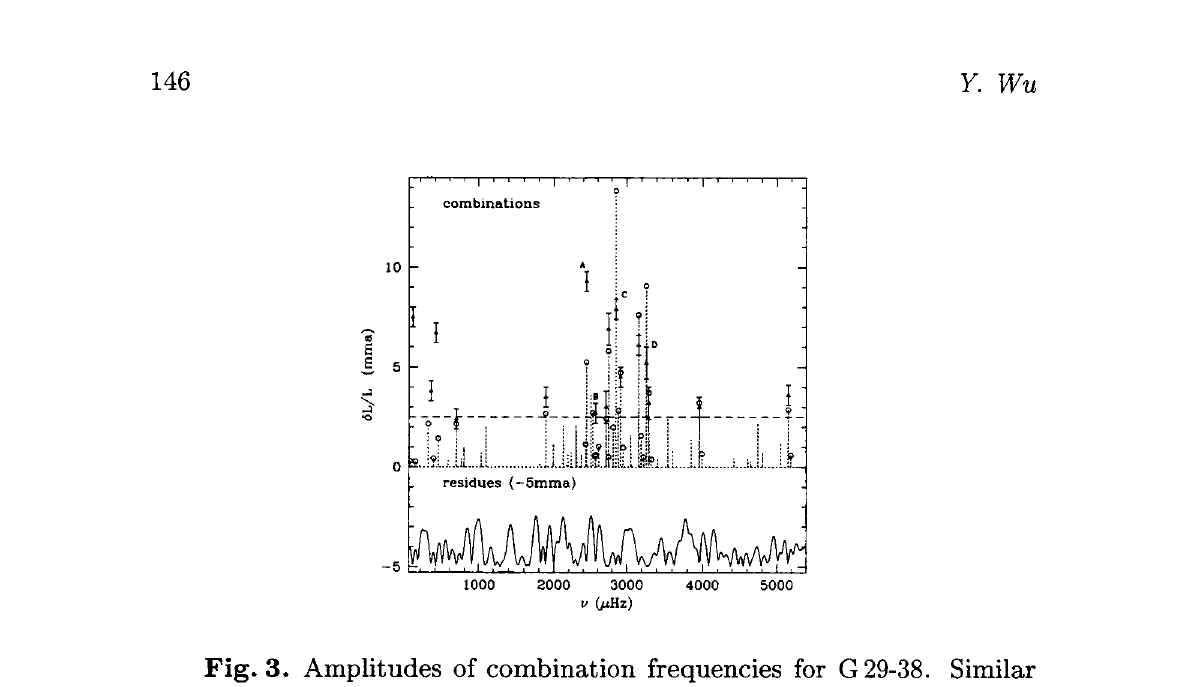
Fig. 3. Amplitudes of combination frequencies for G 29-38. Similar to Fig. 2, only with the horizontal bars substituted with open circles, and with realistic error-bars. We set the frequency identification threshold at